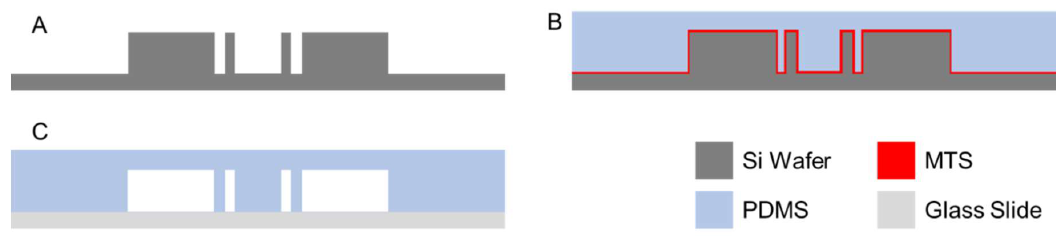
Figure 2. Microfabrication process flow for the fabrication of the single-layer microfluidic device. ( A ) DRIE etch of Si wafer. ( B ) PDMS casting over Si stamp. ( C ) Microfluidic device assembly on glass slide.